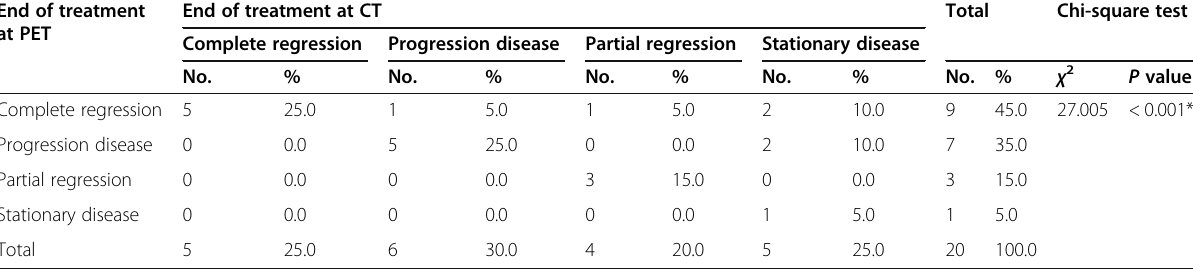
Table 7 Relation between end of treatment at CT and end of treatment at PET of the study group End of treatment End of treatment at CT at PET